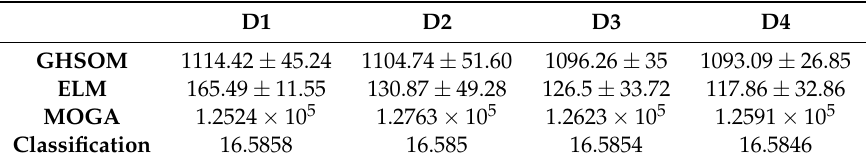
Table 5. Training, optimization, and classification execution times (in